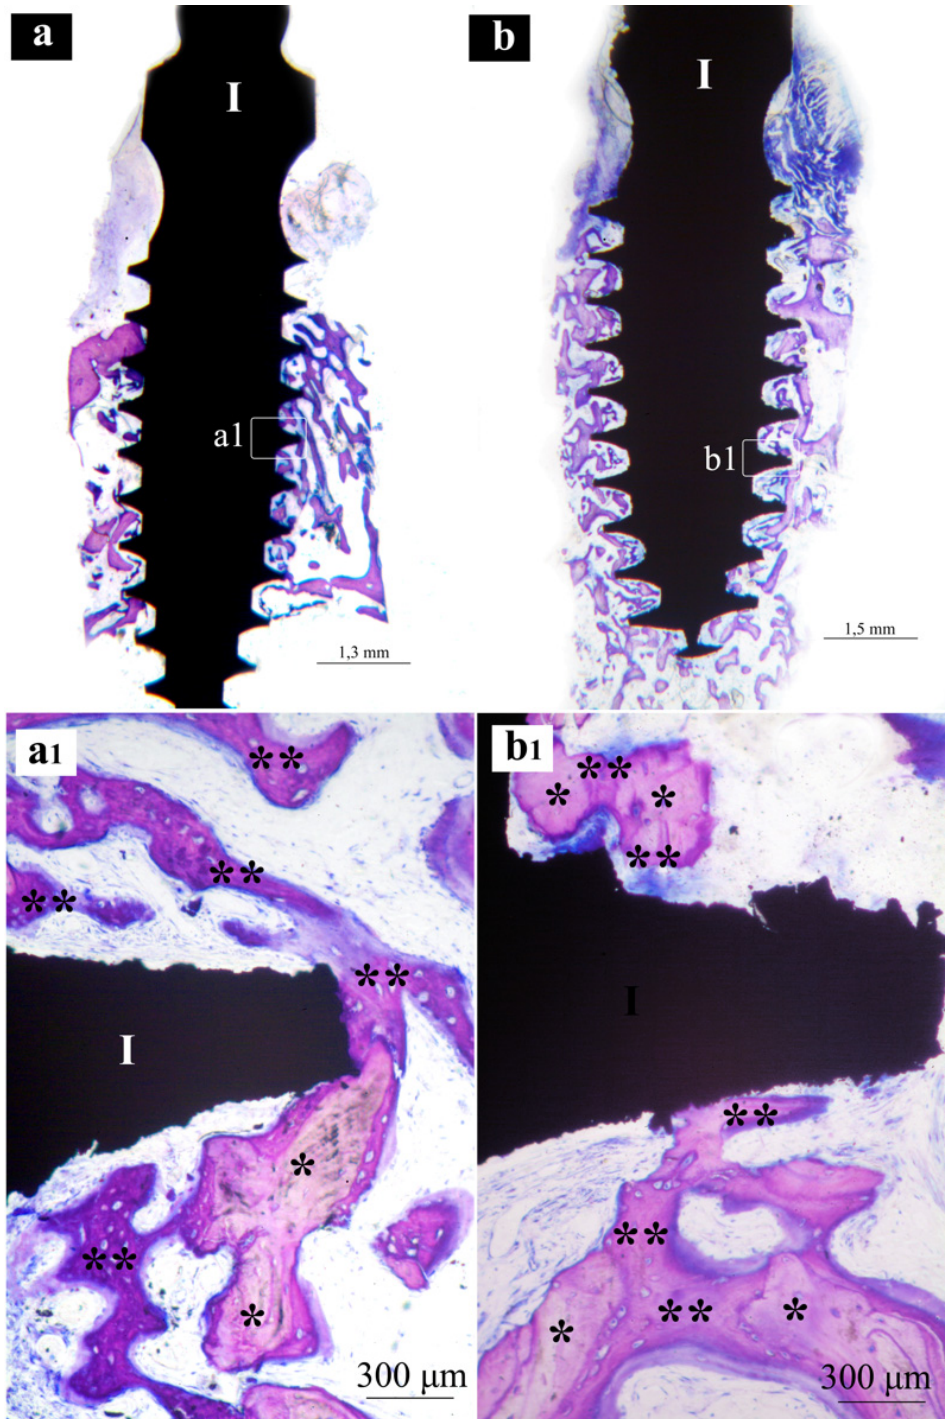
Figure 2. Central sections of two implants of the MAC group after 6 weeks of healing. In ( a , b ), original magnifications ( × 12), the implant bodies (I) appear to be, in the threaded regions, surrounded by much more bone tissue than in Figure 1. In ( a1 , b1 ), original magnifications ( × 200), the implant threads (I) appear to be in a more advanced phase of osseointegration. *, native bone; **, newly formed bone.